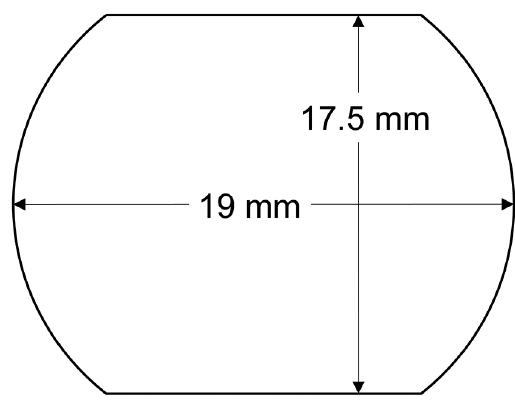
Figure 4: Geometry of the horn tip. The hypothesis that the end of acceleration period in the CWHS specimens is marked by the complete removal of the hardened layer is raised and assessed. For that purpose, the mean depth of erosion at the end of the acceleration period is compared with the cold worked layer thickness. The mean depth of erosion MDE was calculated as described in ASTM G32-10, considering a stainless steel density d of s 7.80g.cm -3 , a cavitation area A of 2.75cm 2 and mass losses c m (at the end of the acceleration period) of 3.4 and 2.53mg, respectively, for the CWHS specimens, equation